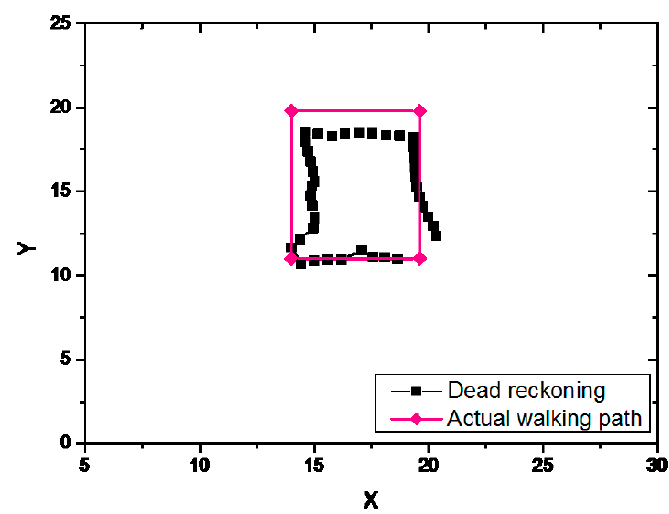
Figure 9. The estimated path and actual walked path of the dead reckoning.